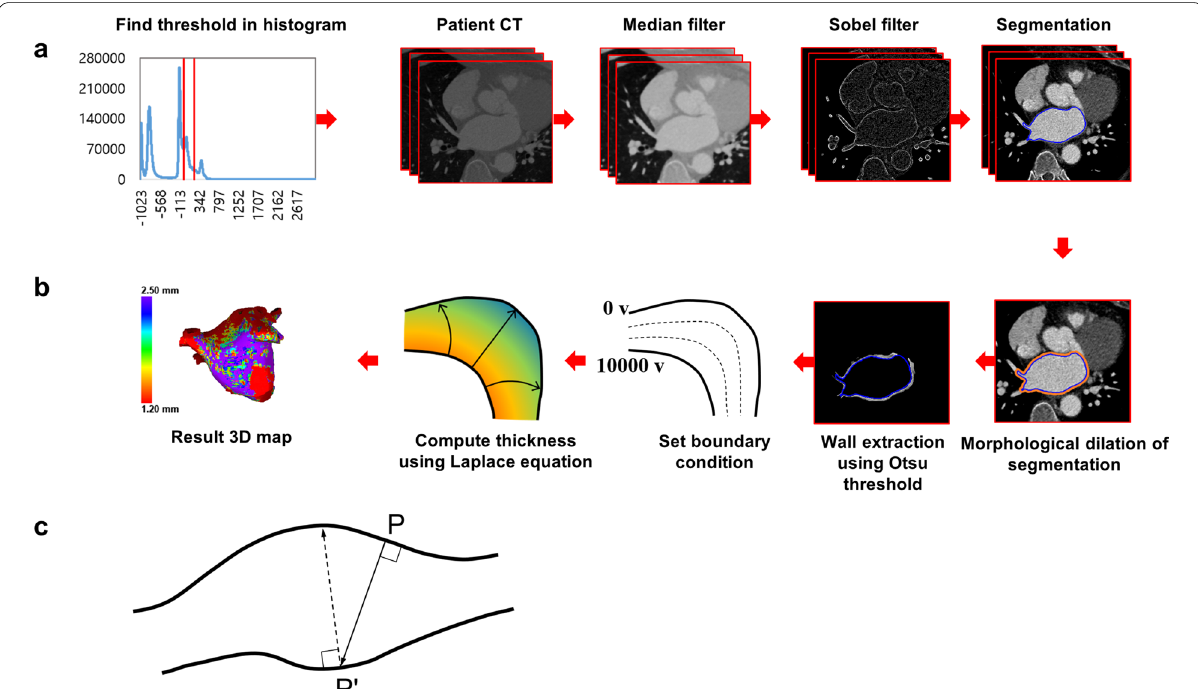
Fig. 2 The detailed procedure for each stage. a The HU thresholds were automatically calculated by the multi‑Otsu algorithm. At the same time, the investigator draws the basic guidelines after image processing. b The myocardial wall extracted based on the morphological dilation and threshold overlap. And the final thickness was calculated by the Laplace equation and Euler methods. c The commutative property of the points P and P ’ by orthogonal projection distances were not suitable in the cardiac